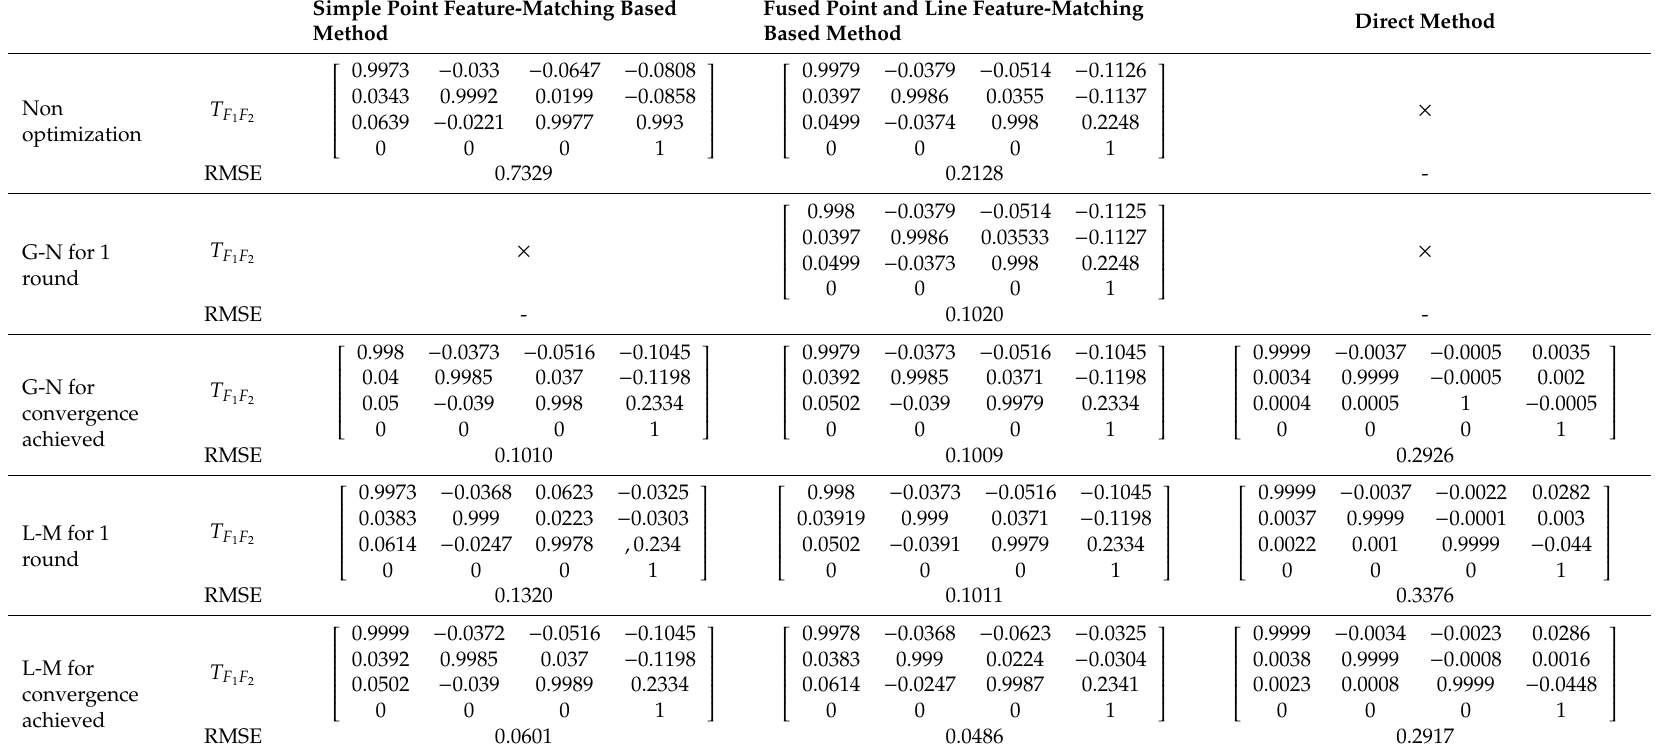
Table 1. The comparative pose measurement